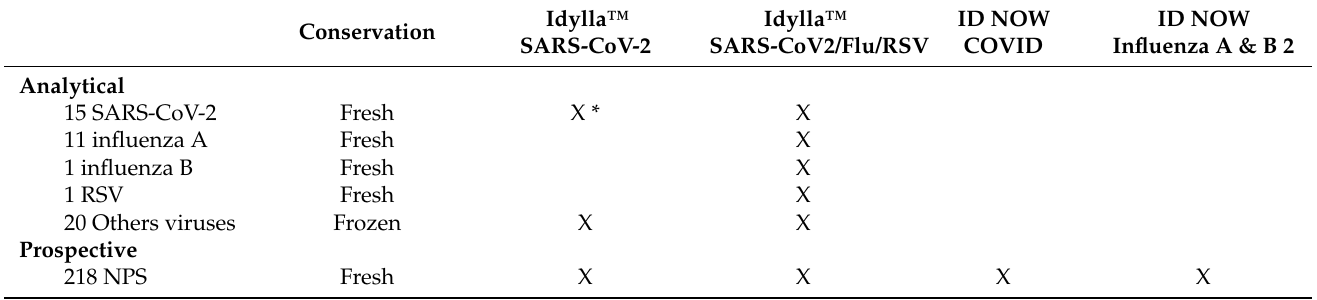
Table 2. Number of NPS and tests performed in the analytical and the prospective studies. Conservation